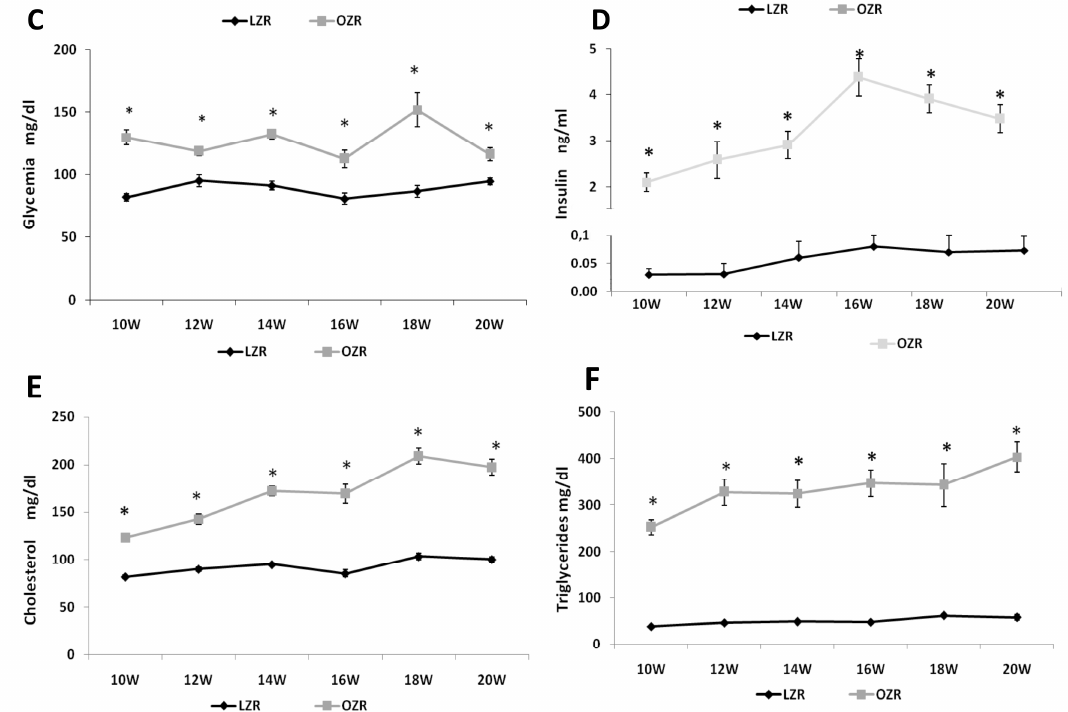
Figure 1. General and blood parameters. Body weight ( A ), food intake ( B ) starting from 10th week of age (first week of housing) to 20th week of age (last sacrifice) for lean Zucker rats (LZR) and obese Zucker rats (OZR). Plasma levels of glucose ( C ), insulin ( D ), total cholesterol ( E ), and triglycerides ( F ) for LZRs and OZRs at different ages. Data are the mean ± SEM. * p < 0.05 vs. age-matched LZR.